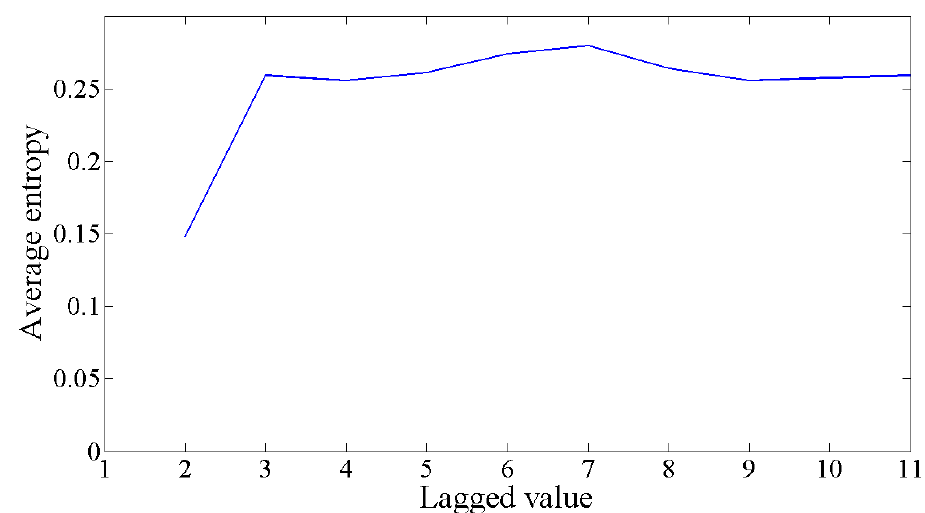
Figure 4. Values of mean entropy for various 𝑇 (cid:3036) size.